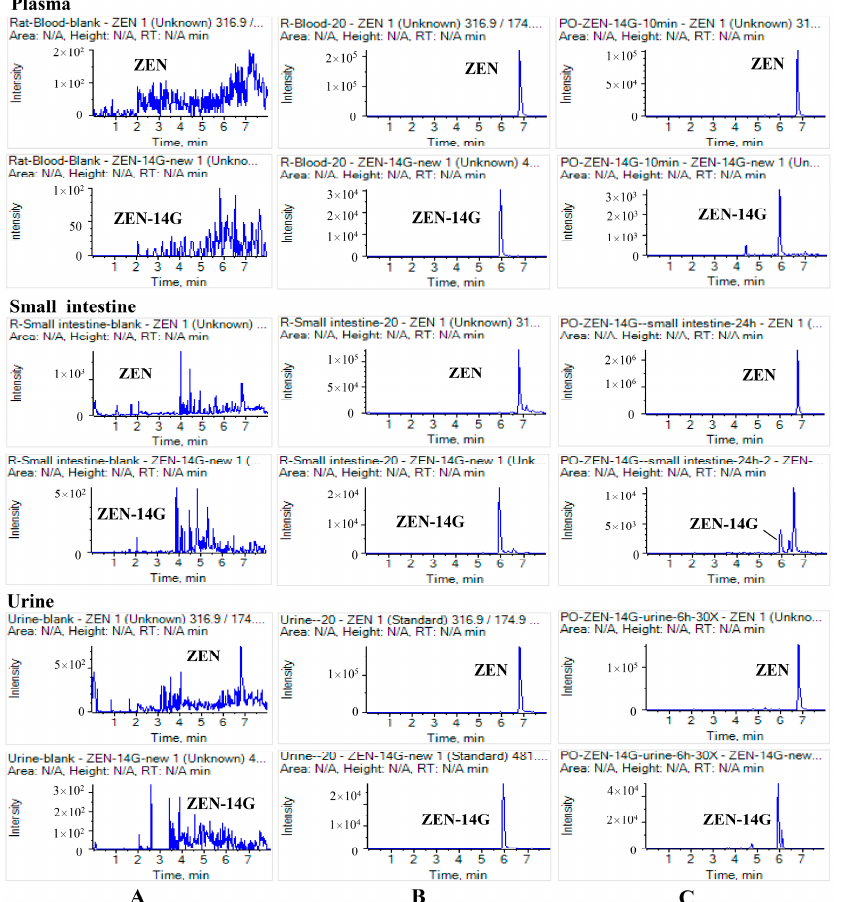
Figure 1. MRM chromatograms of zearalenone (ZEN) and zearalenone-14-glucoside (ZEN-14G) in blank plasma, small intestine, and urine samples ( A ); plasma, small intestine, and urine samples spiked with ZEN and ZEN-14G at the level of 20 µg/L ( B ); and the plasma samples gathered at 10 min, small intestine samples gathered at 24 h, and urine samples gathered at 6 h after the admin- istration of ZEN-14G by gavage (4 mg/kg body weight) in rats ( C ).